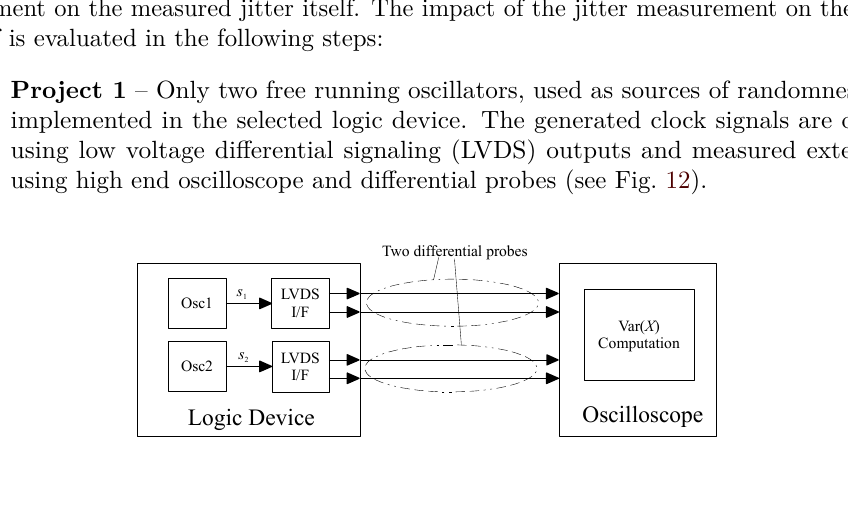
Figure 12: External jitter measurement method using an oscilloscope and differential